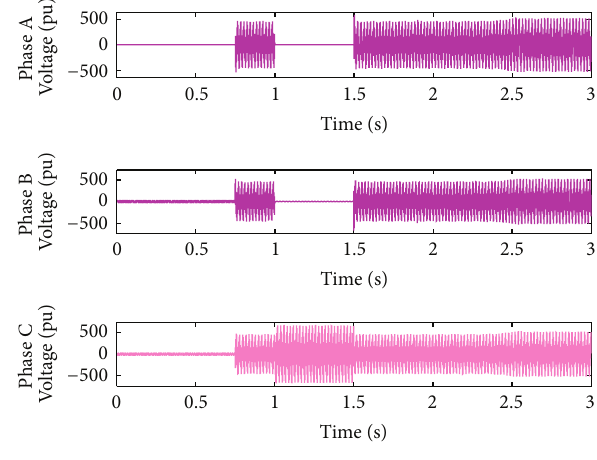
Figure 16: Fault voltage during LLG fault.